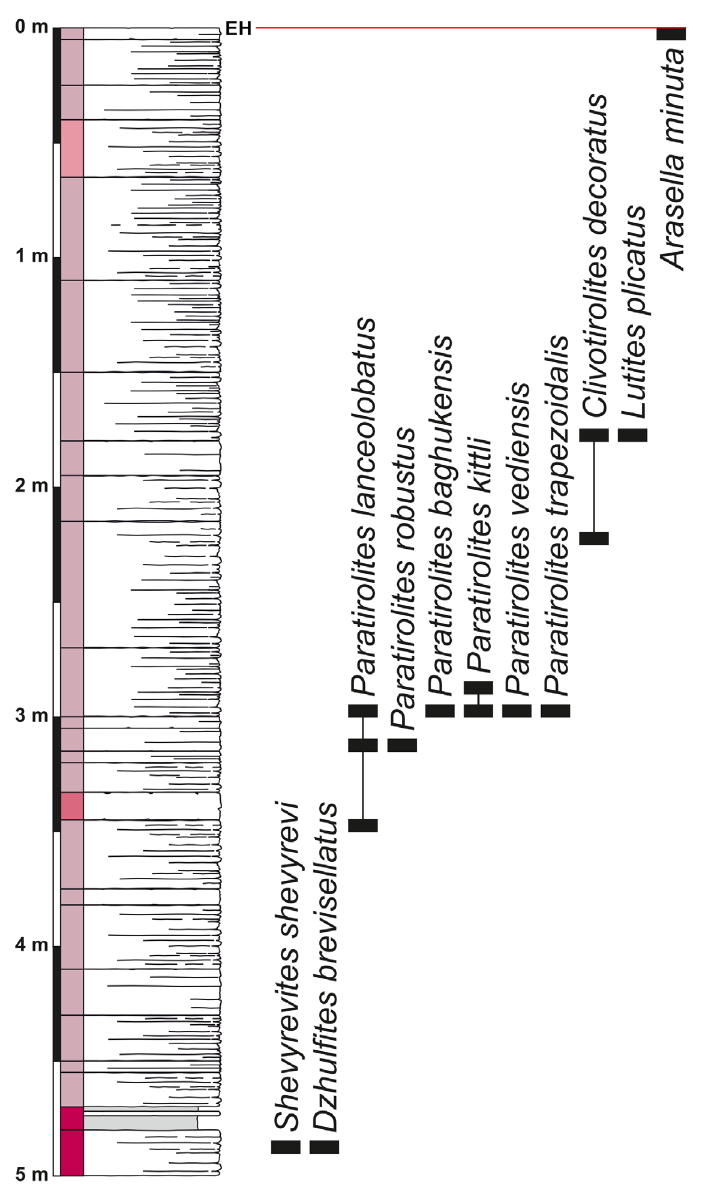
Fig. 7. The stratigraphic occurrence of the ammonoid species in the upper part of the Hambast Formation at Baghuk Mountain E section. EH = extinction